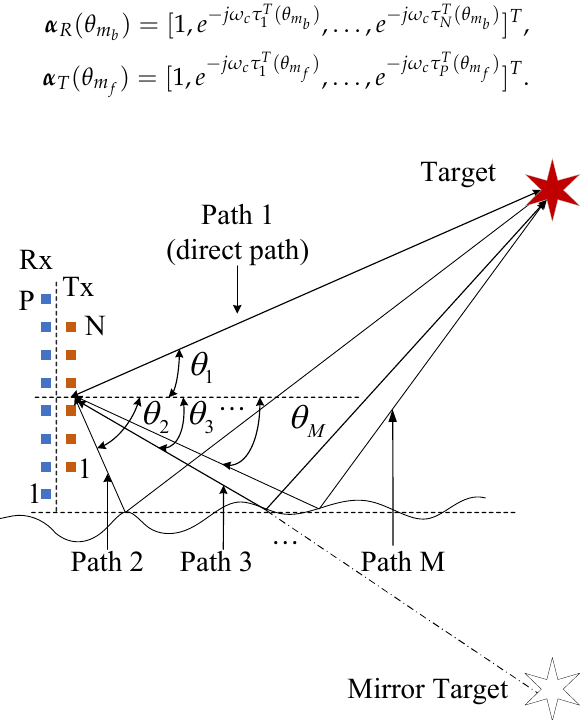
Figure 1. Schematic diagram of multipath system